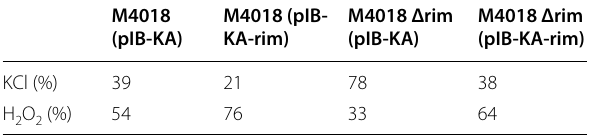
M4018 (pIB-KA): parental strain M4018 with a control plasmid pIB-KA; M4018 (pIB-KA-rim): rimA1A2 -overexpressed mutant derived from M4018; M4018 Δrim (pIB-KA): rimA1 -disrupted mutant M4018 Δrim with a control plasmid pIB-KA; M4018 Δrim (pIB-KA-rim): rimA1A2 -complemented mutant derived from M4018